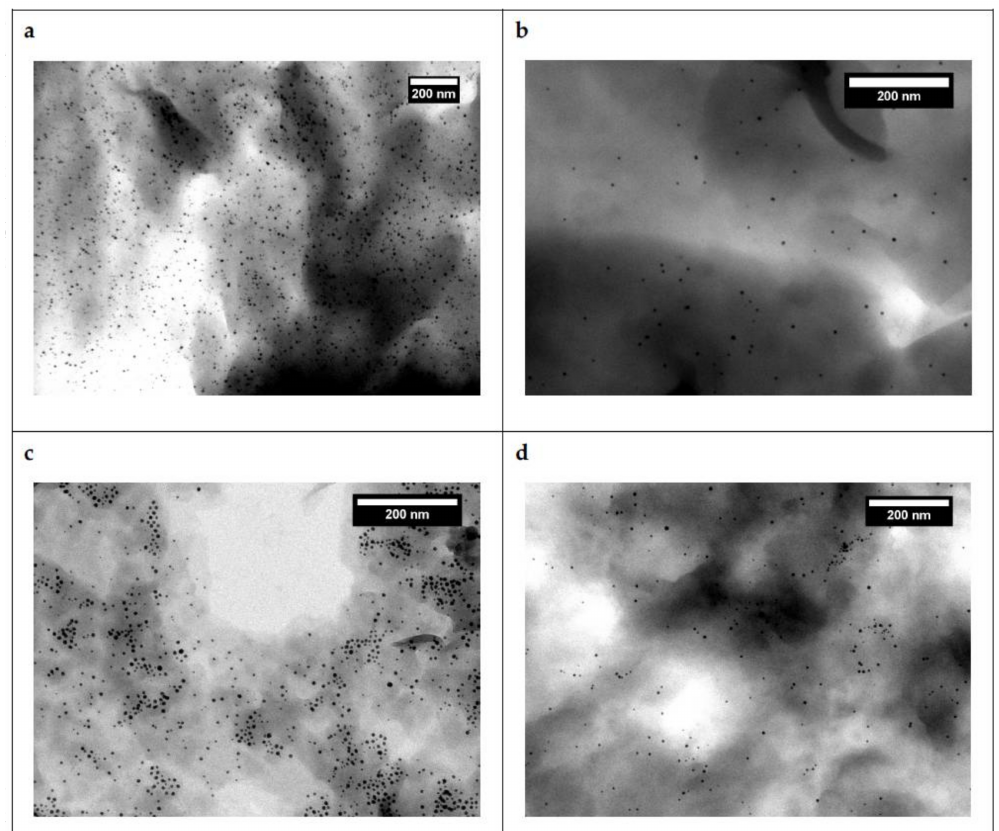
Figure 3. TE micrographs of dispersed PE–AuNPs with a high ( a ) and low ( b ) particle content and for PE–AgNPs with high ( c ) and low ( d ) particle content in a polyethylene